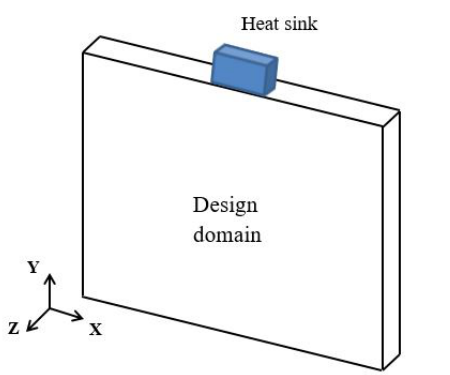
Figure 9. Schematic of the design domain for the heat conduction